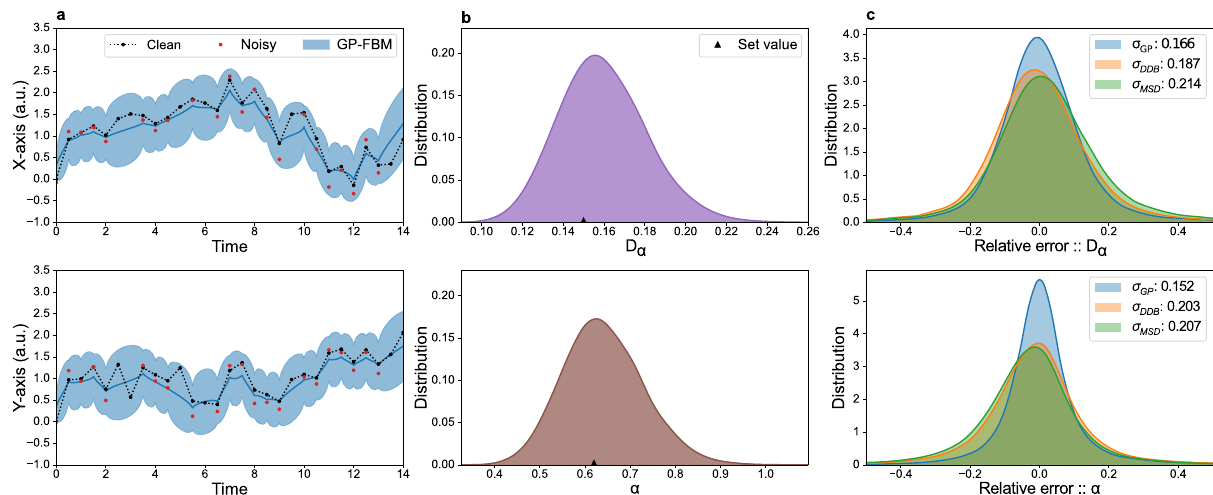
Fig. 1 GP-FBM outperforms existing methods on simulated data. ( a ) 2D trajectory sampled from a GP with the FBM kernel displayed in black. To match observed experimental trajectories in the following sections, Gaussian noise of 1/10 of a pixel is added to the positions and 10% of the points are removed according to a uniform random distribution. The noisy trajectory is displayed in red. The blue line shows the most probable trajectory with the blue shaded band representing the 95% credible interval as inferred by GP-FBM. ( b ) Posterior probability distributions for D α and α inferred from trajectory in (a). Triangles denote the values set in the simulation. ( c ) Comparing inference relative errors as obtained by GP-FBM (blue), MSD (green) and DDB (orange) for 50000 simulated trajectories with uniform random parameters chosen in the range 0.01 < D α < 1.5, 0.01 < α < 1.9, 0.1 < dt < 1.0, 0.001 < σ < 0.25 and 0 < o <